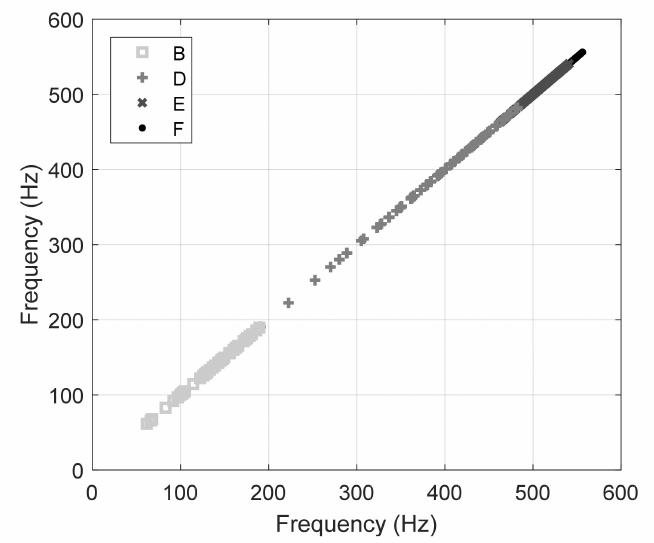
Figure 13. RFEA Mode Shape Distributions. Note the overlap between D, E, and